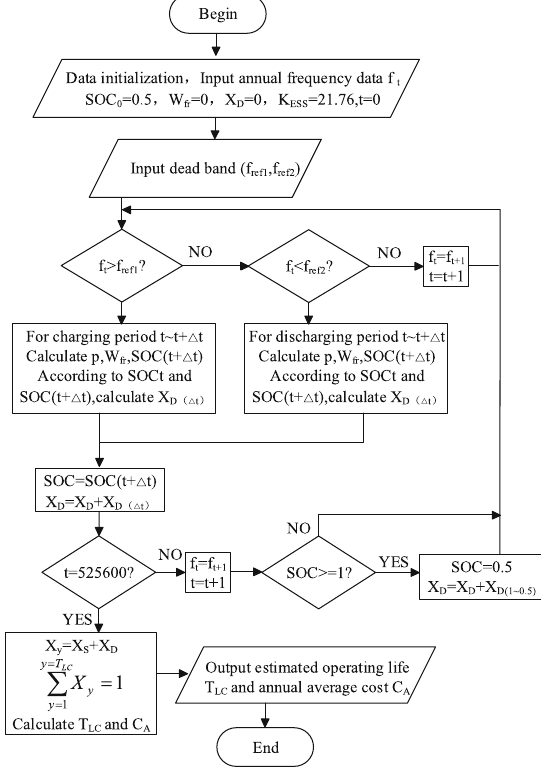
Fig. 3 The calculation flowchart of Li-ion ESS estimated operating life and annual average cost